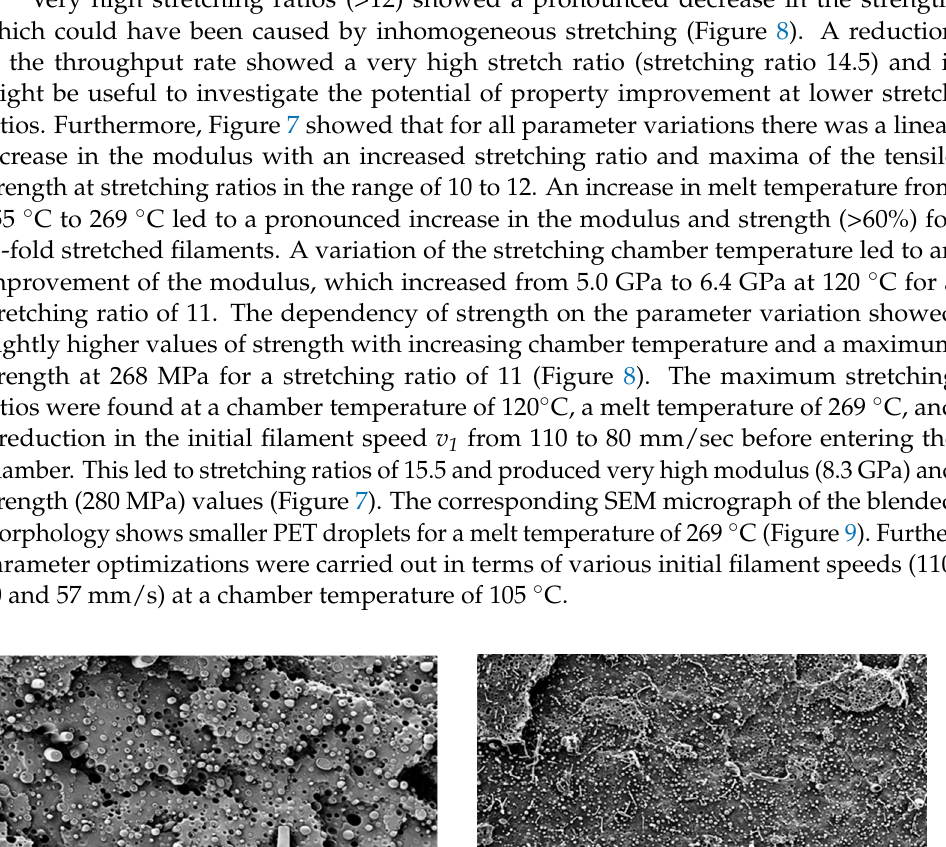
Figure 10. Young's modulus of the stretched PP with 22 wt% PET filaments as a function of the stretching ratio for different initial filament speeds v 1 before entering the chamber.